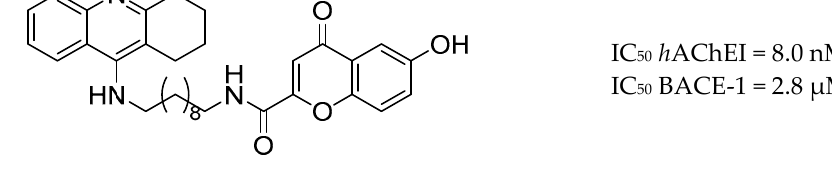
Figure 4. The most active tacrine and 4-oxo-4 H -chromene hybrid from [138].